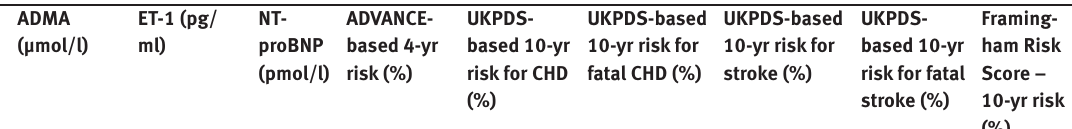
Table 2: The correlation and coefficients and regression models linking the anthropometric and body composition indices (independent var- iables) with the biochemical/endothelial markers and the calculated cardiovascular risks (dependent variables) are shown. The significant Spearman’s Rho Rank coefficients are